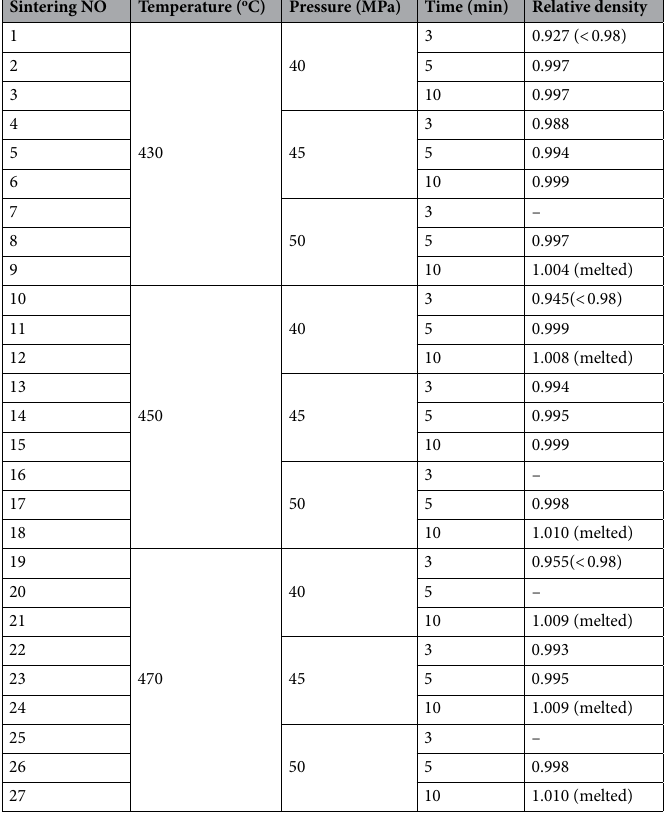
Table 1. Relative density of the various sintering Mg alloy